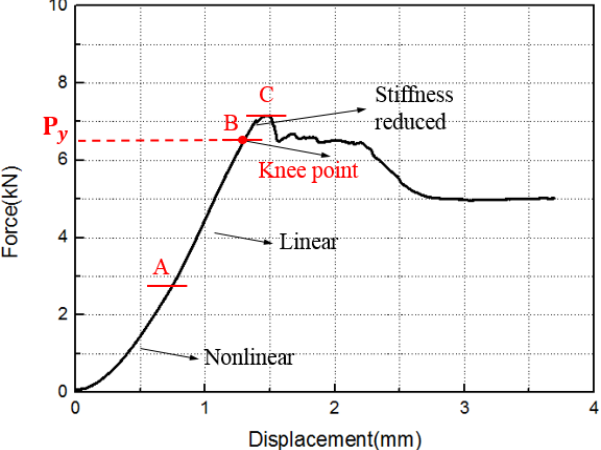
Figure 16. Initial load–displacement curve of the hexagonal bolt joints at 600 °C .